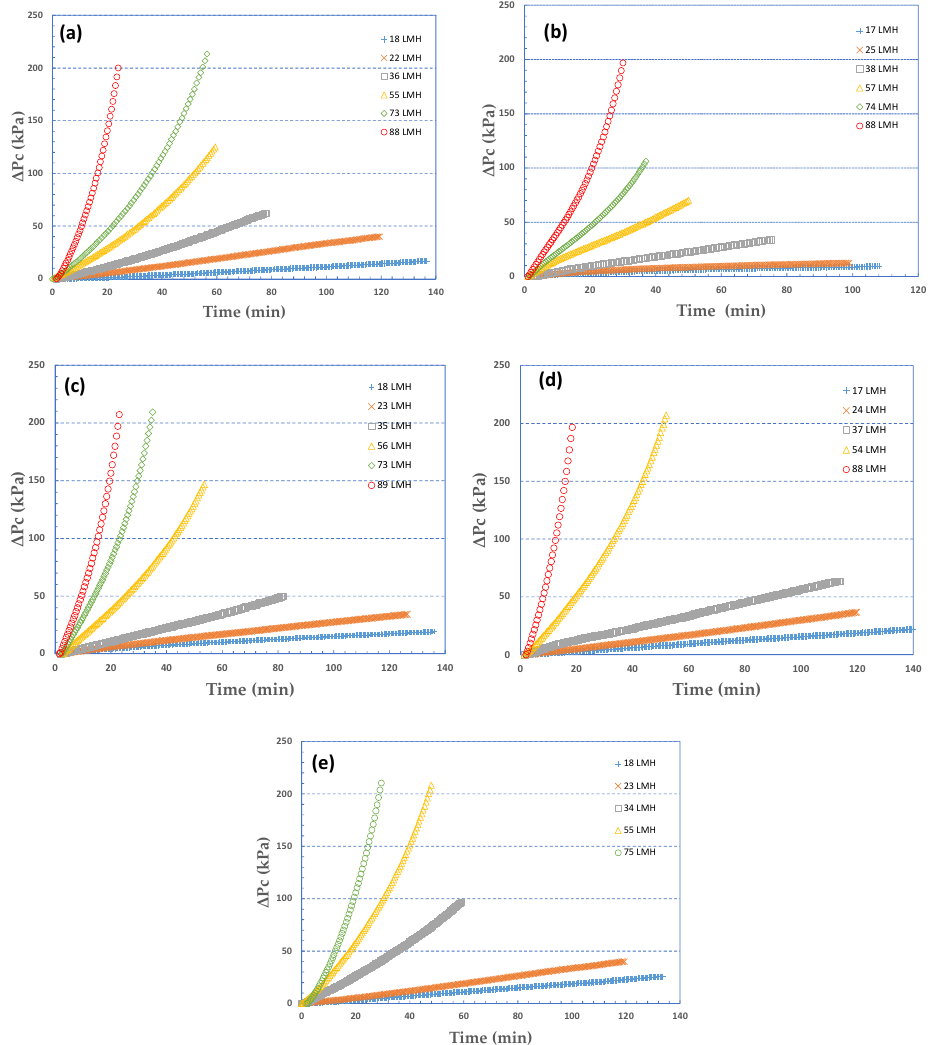
Figure 1. Temporal variation of pressure drop due to fouling, ∆ P c , for various constant fluxes J and five feed-fluid foulants composition. Fouling species: ( a ) 100% SA, ( b ) 100% BSA, ( c ) 25% SA-75% BSA, ( d ) 50% SA-50% BSA, ( e ) 75% SA-25% BSA.